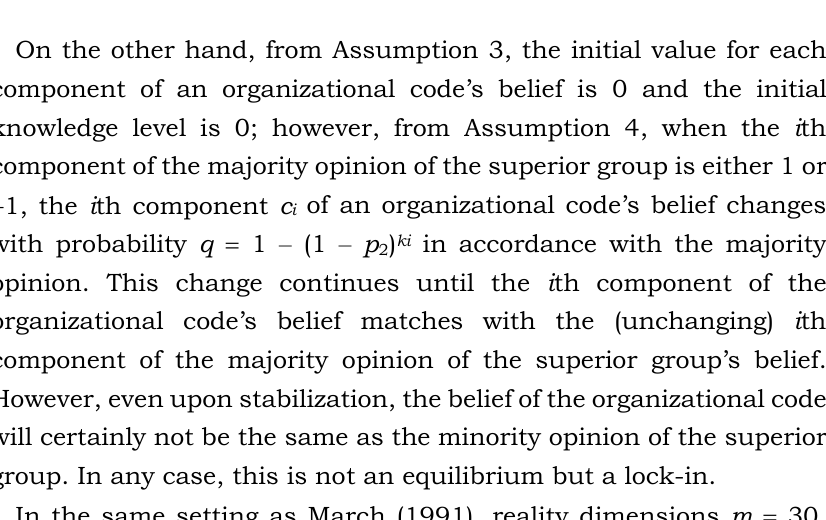
Table 2. Average knowledge levels at the learning rate p 1  0 p 1